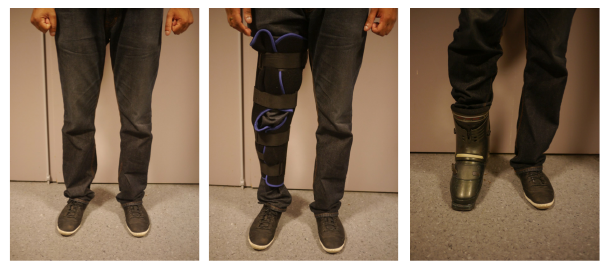
Figure 20. Mechanical disturbances on the subject: normal (left), right knee immobilization (center) and ski boot on right foot (right)